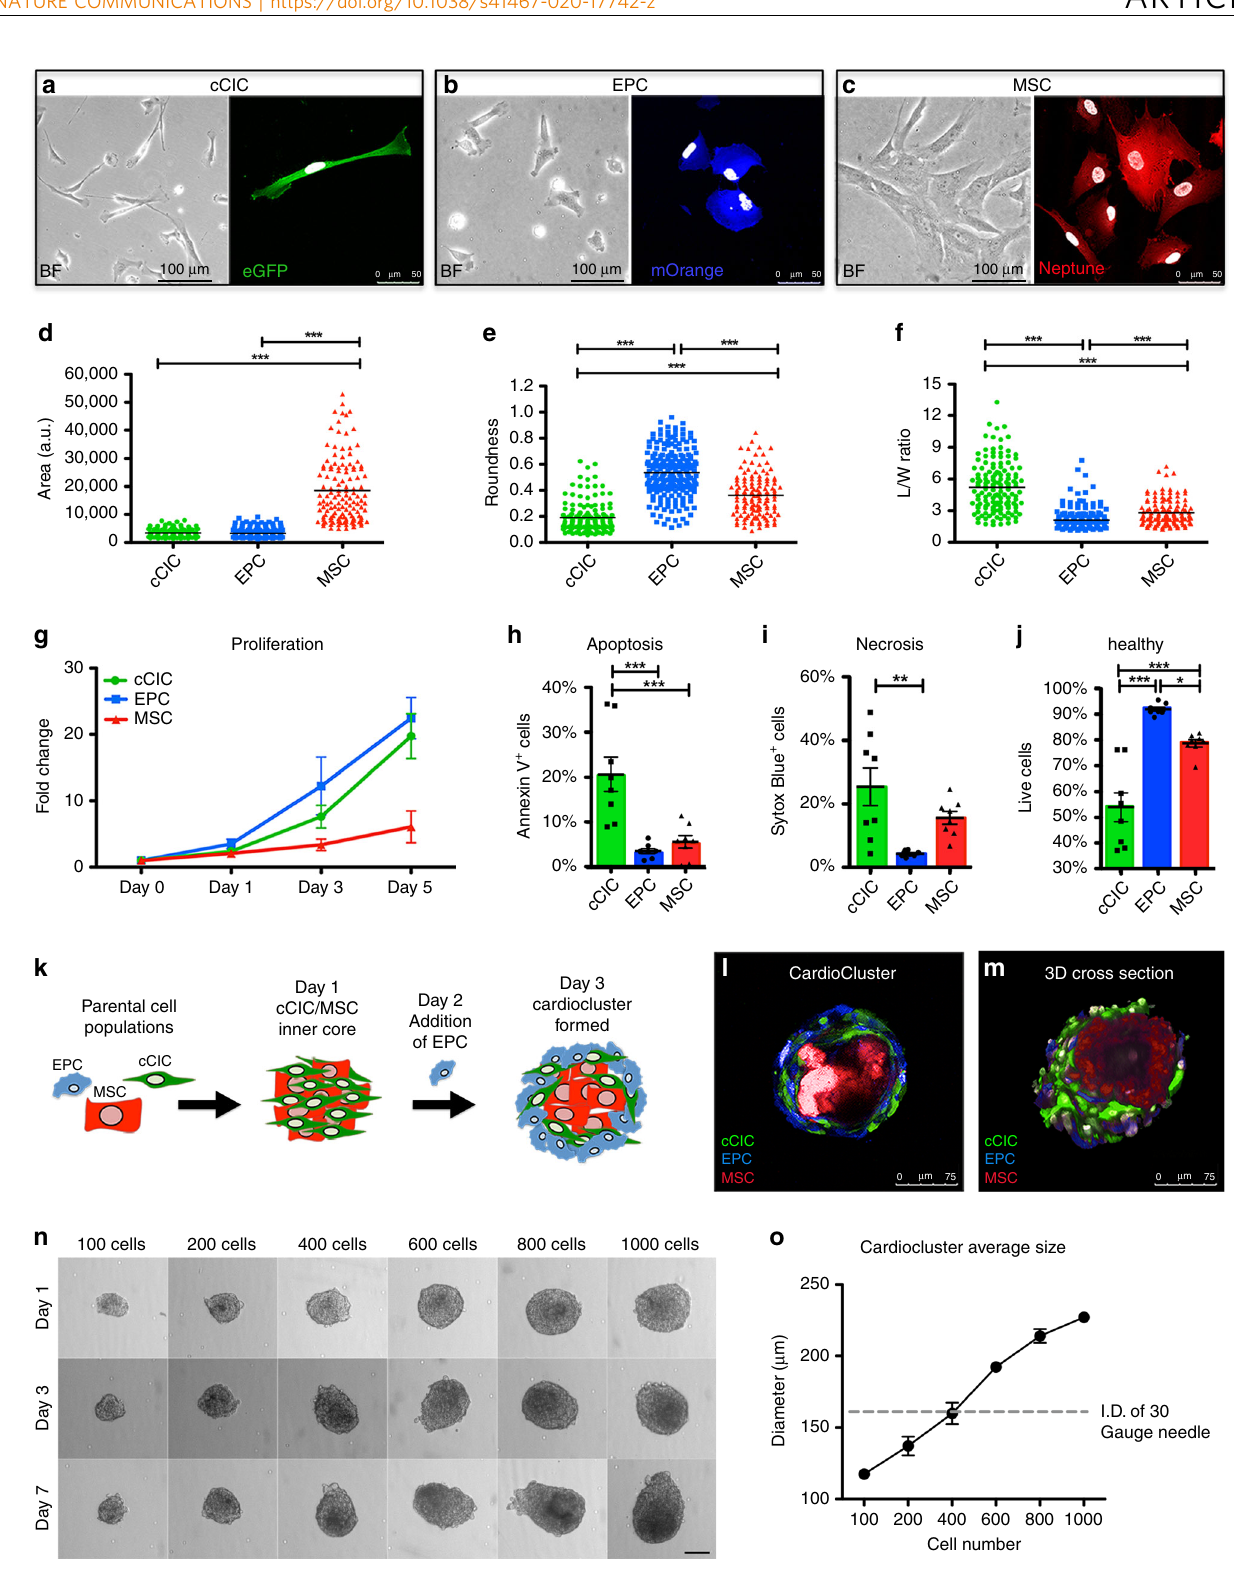
Fig. 2a, b). Distinct morphology for each cell population is evident in representative bright fi eld images with companion immuno fl uorescent images demonstrating corresponding fl uor- ophore expression in cCICs (Fig. 1a), EPCs (Fig. 1b), and MSCs (Fig. 1c). Cell morphology measurement of area, roundness, and L/W ratio for each cell type con fi rmed distinct phenotypes (Fig. 1d – f). MSCs were signi fi cantly larger (18,563 ± 1,021)